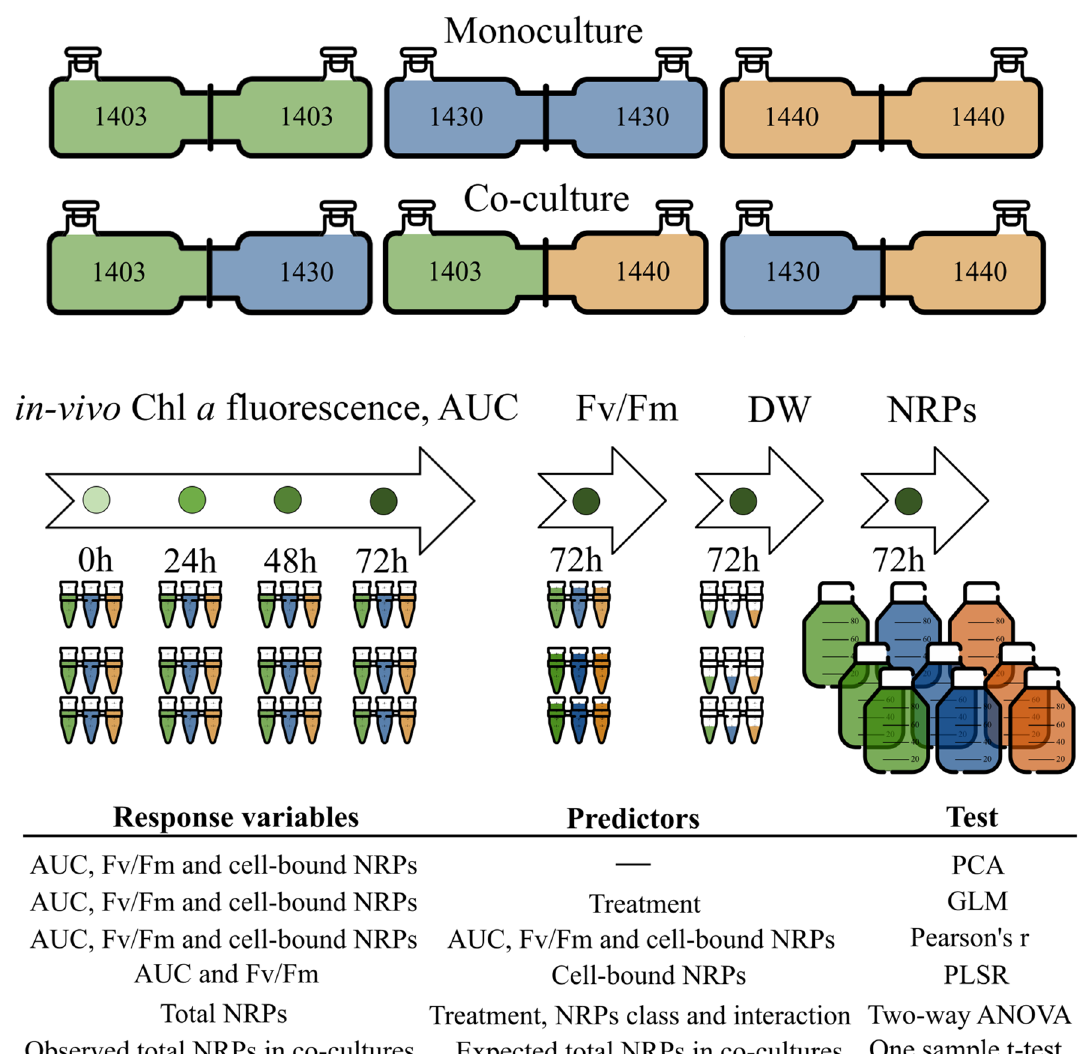
Figure 1. Schematic representation of the experimental design. Each treatment, e.g., monocultures 1403/1403, 1430/1430, 1440/1440 and co-cultures 1403/1430, 1403/1440 and 1430/1440, were performed in triplicate. The initial biomass of the cyanobacterium was the same among the treatments. Samples for growth assessment (area under the growth curve, AUC) were taken as a time series (0 h, 24 h, 48 h and 72 h). Samples for photosystem II maximum yield (Fv/Fm), dry weight (DW), cell-bound and extracellular non-ribosomal peptides (NRPs) were taken at the time point 72 h. Statistical methods included PCA, Principal Components Analysis; GLM, Generalized linear models; Pearson correlation; Spearman’s rank correlation; Two-way Anova including post- hoc analysis with Tukey’s HSD test and One sample t-test. This image has been designed using resources from